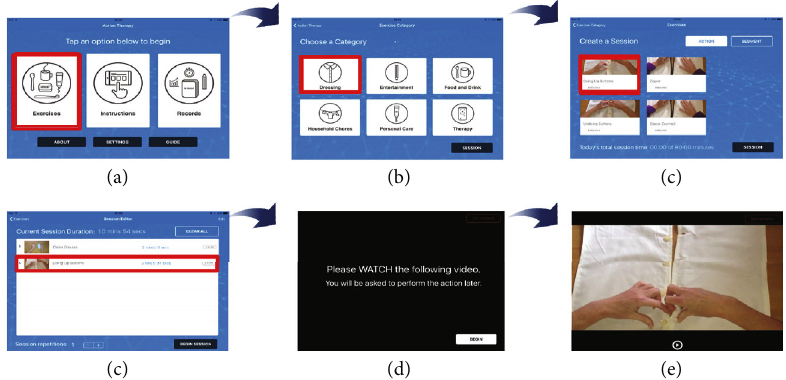
Figure 1: The schematic illustrates how an exercise session is created and executed. In a typical session a user would (a) select the exercise programme; (b) select an ADL category; (c) select an action(s) from within the category, using the top right-hand buttons to toggle between action or segment ; (d) add the action(s) to the exercise session; (e) start the session; and (f) begin SIMULATe training (in this example, doing up buttons from a fi rst-person visual perspective is presented). Note: prior to selecting the exercise program, the dominant hand is selected in the default settings.